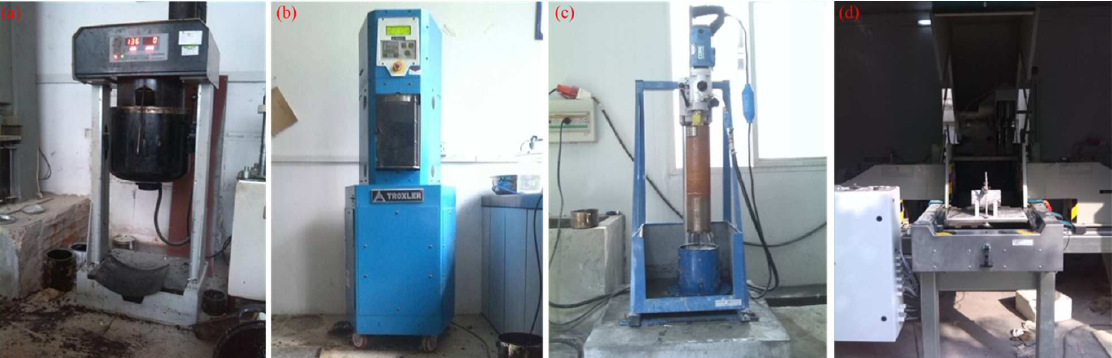
Figure 1. Experimental equipment; ( a ) asphalt mixture mixing pot; ( b ) rotary compactor; ( c ) indoor core machine; ( d ) grinding of specimen.